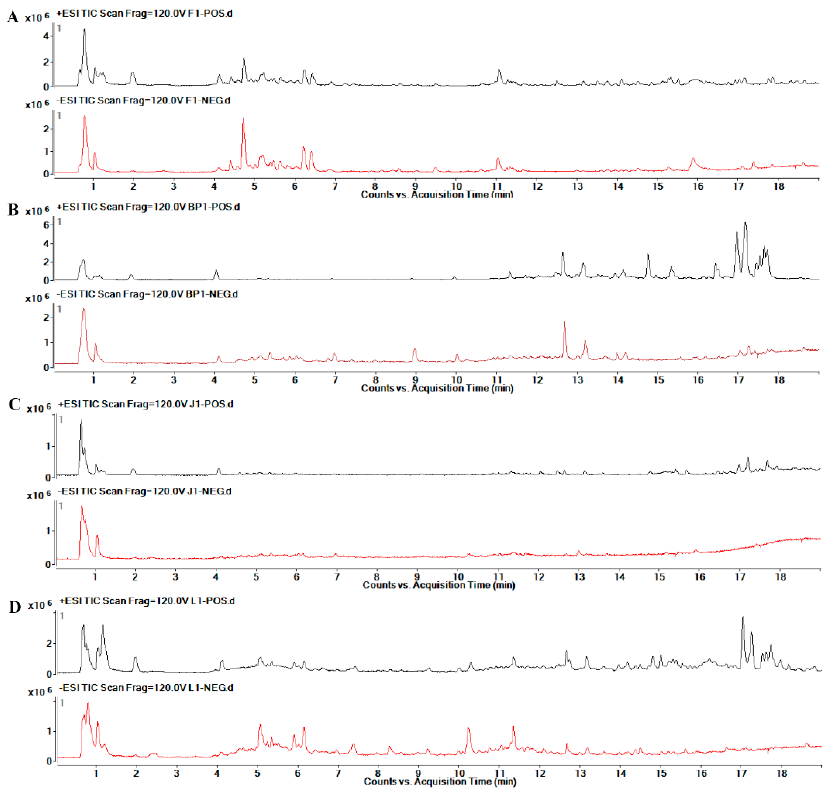
Figure 6. Representative total ion chromatograms (TICs) in electrospray ionization source (ESI) positive and negative ion mode from four different parts of safflower based on UHPLC-Q-TOFMS: ( A ) F, ( B ) BP, ( C ) J, ( D ) L.